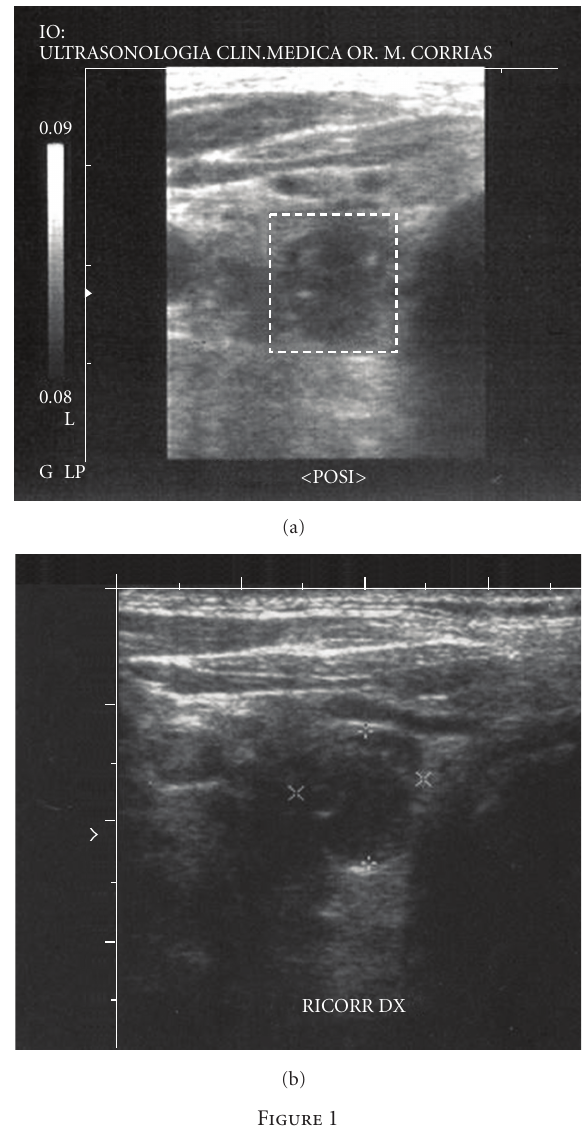
PTH (150–300 ρ g/ml), serum calcium (8.4–9.5 mg/dl),